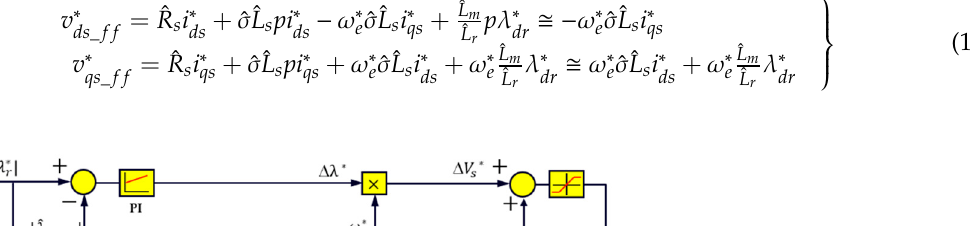
Figure 9. Rotor field-oriented control (RFOC) scheme.